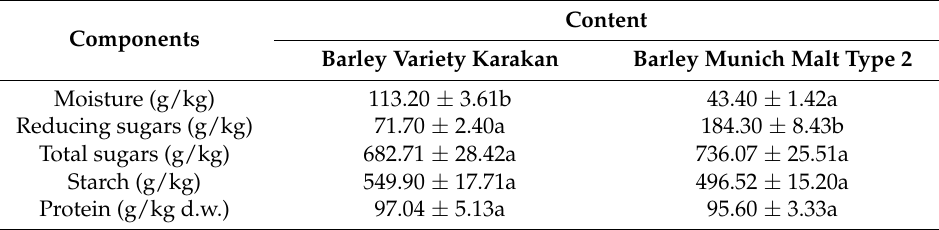
Table 1. The chemical composition of raw